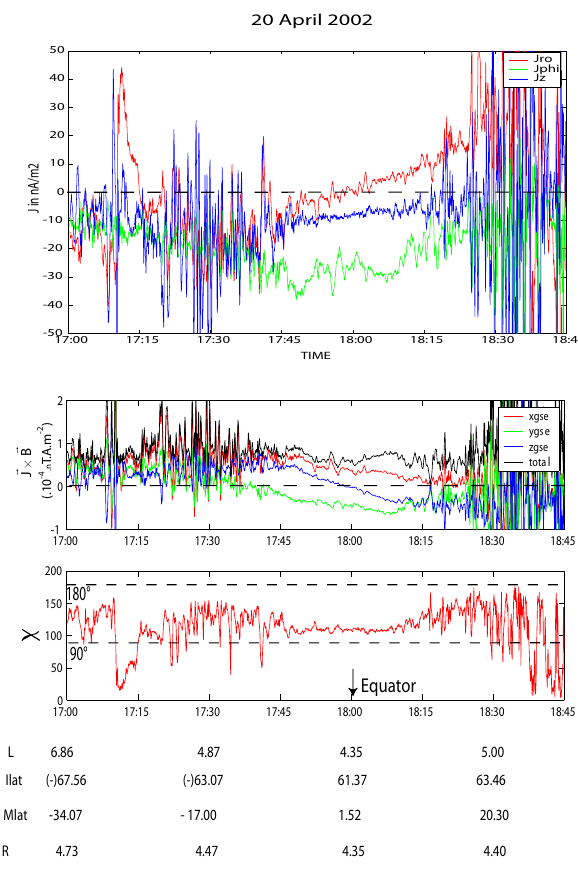
Fig. 14. Curlometer results for the 20 April 2002 event. From top to bottom: current density in the local cylindrical coordinate sys- tem and in nA.m − 2 , pressure gradient (computed from J × B ) , and χ angle between local current flow and magnetic field. L-shell, invariant latitudes, magnetic latitudes and geocentric distances are indicated at the bottom of the